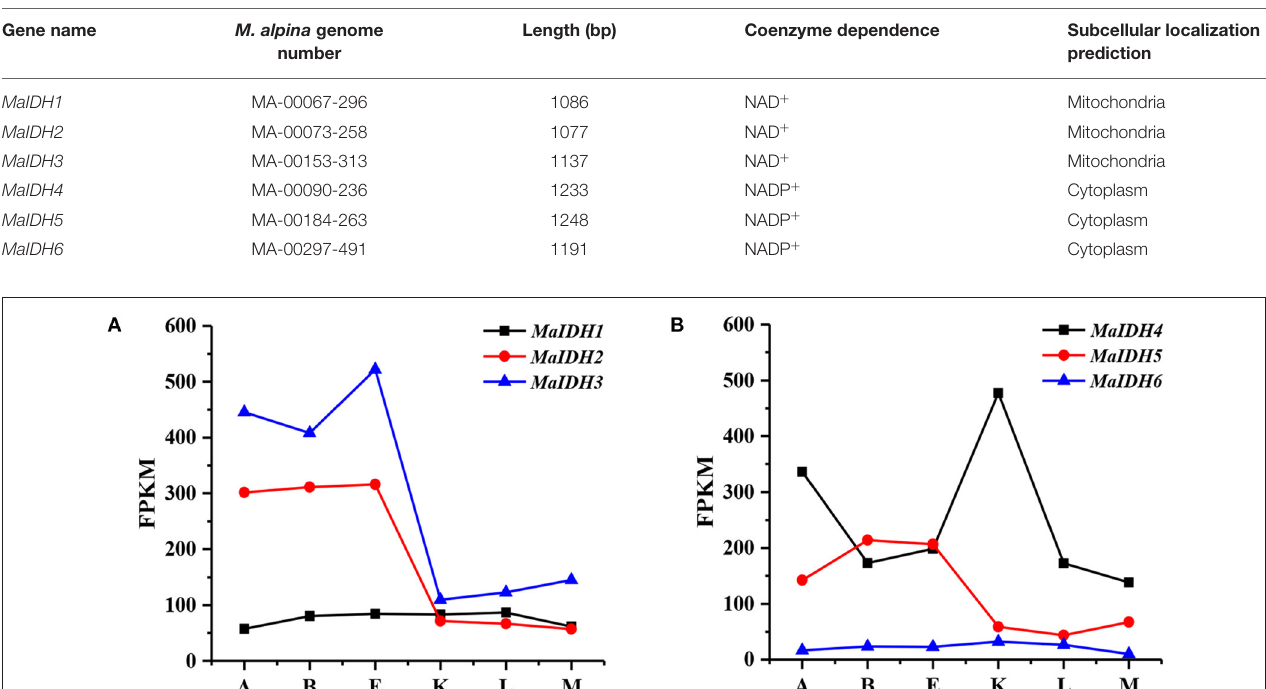
FIGURE 1 | Transcriptome level analysis of isocitrate dehydrogenases from M. alpina (MaIDHs) at different time points during the fermentation process. A–K indicate various time points prior to and after nitrogen exhaustion, A: − 12h, B: − 2h, E: − 30min, K: + 1h, L: + 12h, and M: + 48h. (A) FPKM of NAD + -MaIDHs, (B) FPKM of NADP + -MaIDHs.